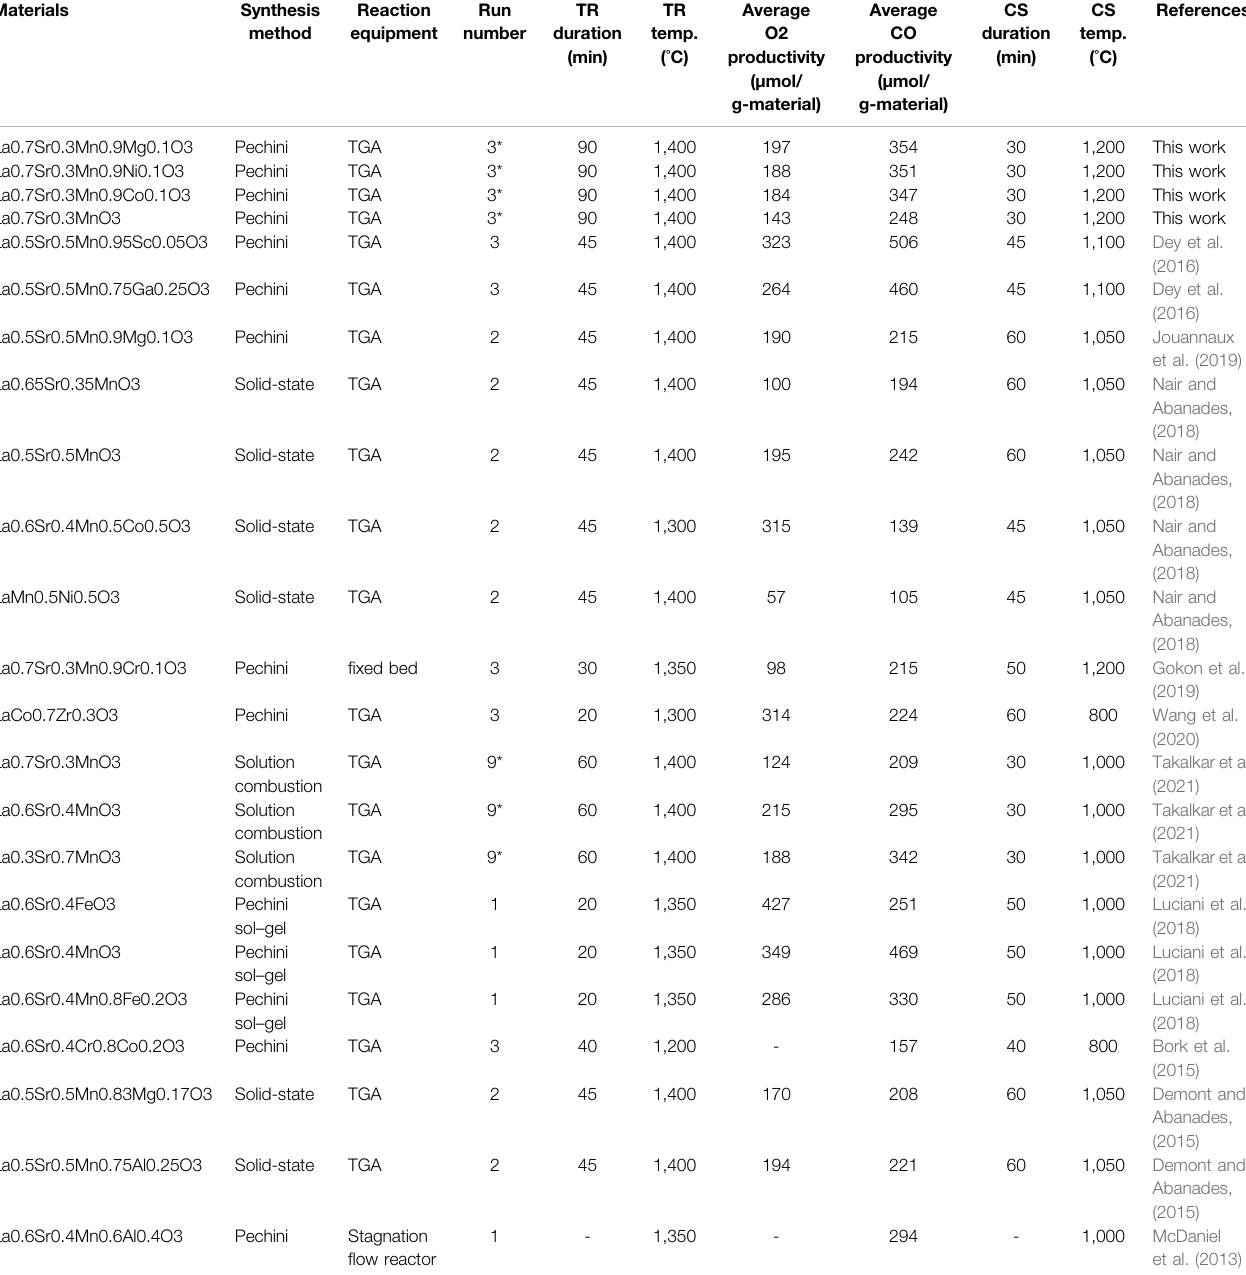
TABLE 4 | Comparison of main results in the present study and previous literatures for thermochemical two-step CO 2 splitting using the LSM